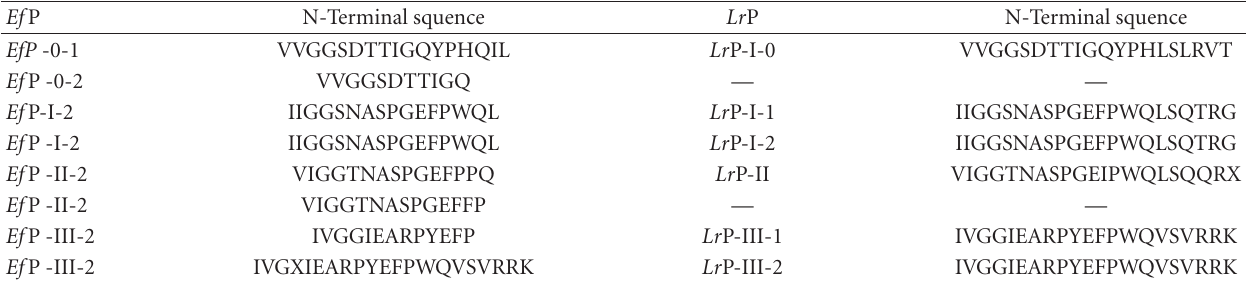
Table 3: The N-terminal sequences of the